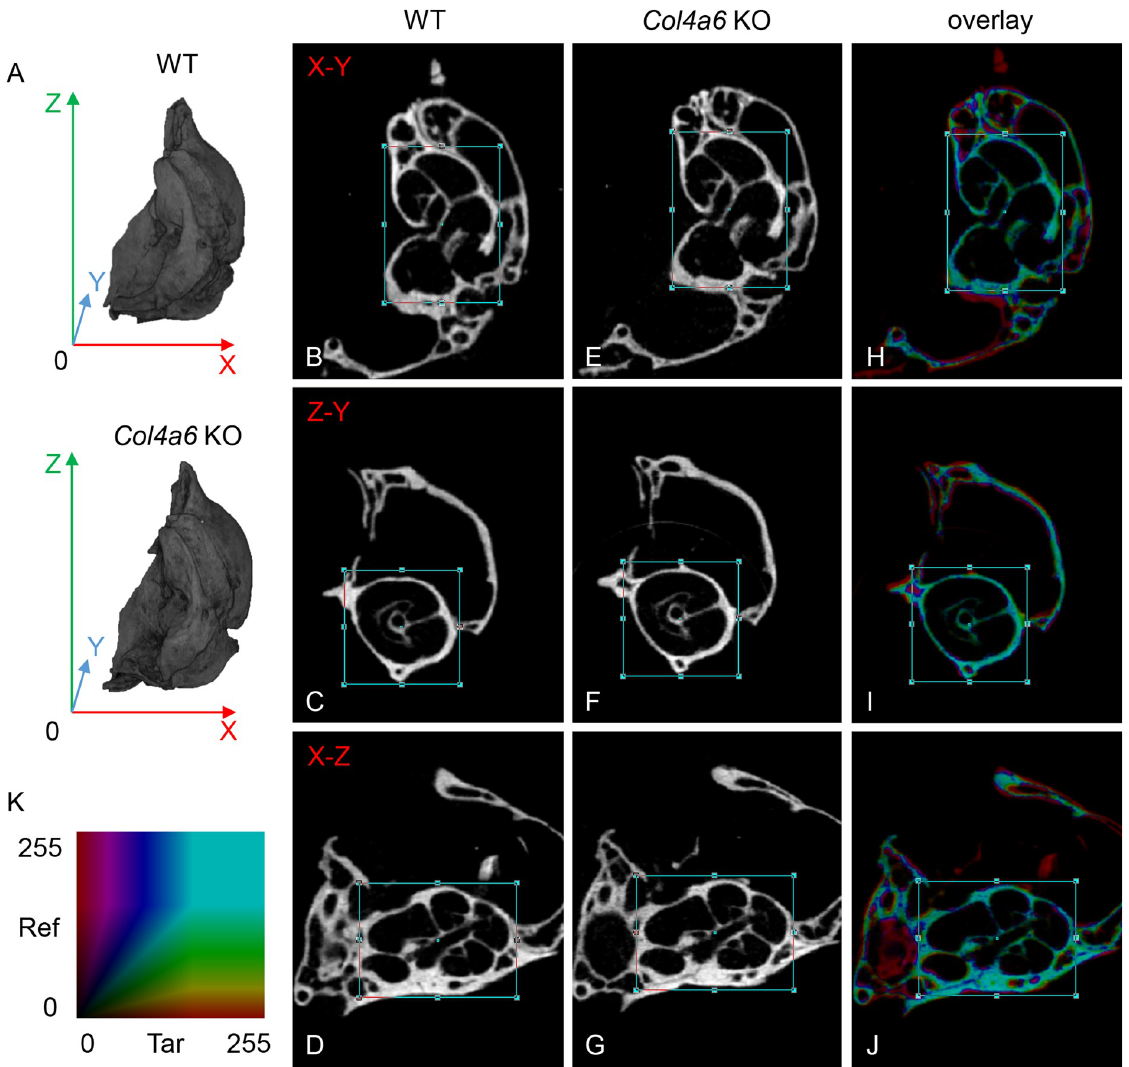
Fig 5. Comparison of the cochlea bone structure of WT and Col4a6 KO mice by micro-CT analysis. (A) Representative three- dimensional images of the petrous portion of the left temporal bone in WT and Col4a6 KO mice. The top shows the apex of petrous in the superior view. (B–G) The three orthogonal plane images were automatically obtained as a best-matched plane from the Col4a6 KO data set compared to the images manually selected from the cochlea structure of the WT mice data set. (H–J) The overlay images demonstrated that no differences in the size or shape are apparent in the cochlear bone between WT and Col4a6 KO mice. Blue squares represent the Volume of Interest. (K) Light blue color indicates a highly matched degree based on the color